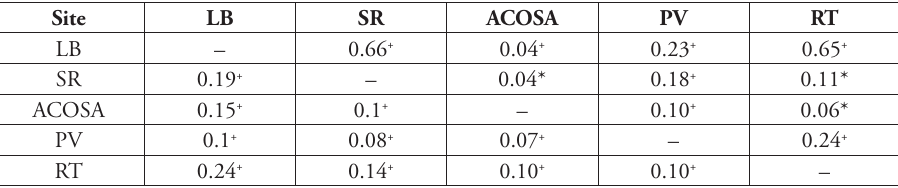
Table 4. Population differentiation between all Crocodylus acutus population pairs using R line) and F (below 0 line). ST